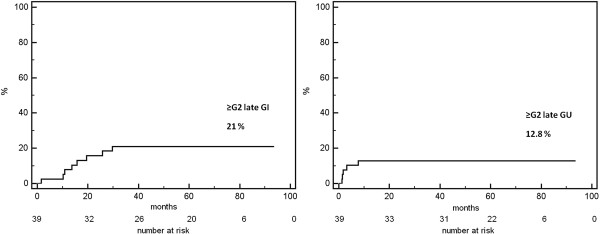
Actuarial incidence of ≥ G2 late GI and GU toxicity.